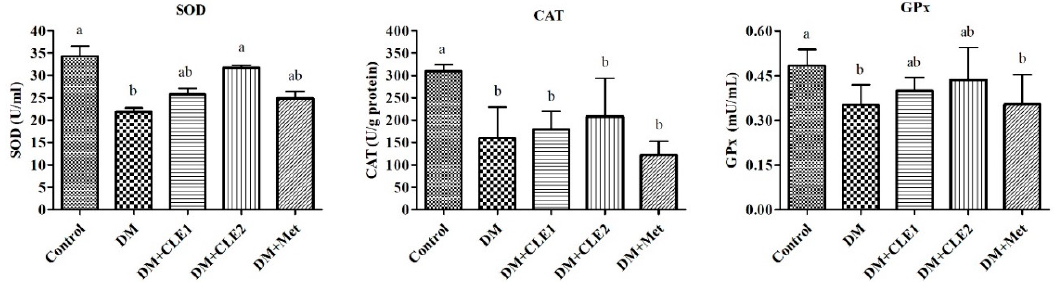
Figure 3. The SOD, CAT, and GPx activities in the plasma of diabetic mice after treatment for 6 weeks. Data are shown as mean ± SD ( n = 5). The values with different letters (a–b) represent significant difference ( p < 0.05) as analyzed by a Duncan’s multiple range test. SOD, superoxide dismutase; CAT, catalase; GPx, glutathione peroxidase; DM, diabetes; DM + CLE1, diabetes and 600 mg / kg of C. lentillifera ; DM + CLE2, diabetes and 1000 mg / kg of C. lentillifera ; DM + Met, diabetes and 200 mg / kg of metformin. Lipid peroxidation (MDA) in the testis was determined after 6 weeks treatment with C. lentillifera